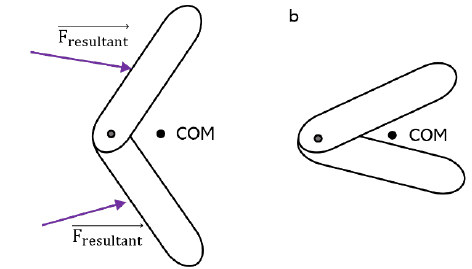
Figure B2. Diagram of forces acting on connected rigid bodies.